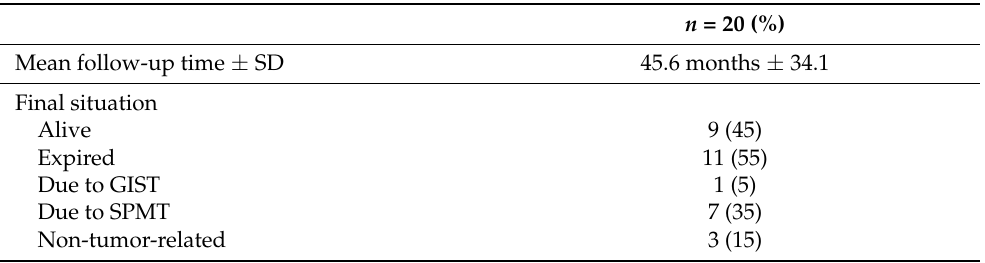
Table 4. Follow ‐ up and survival results of the patients. Table 4. Follow-up and survival results of the patients.